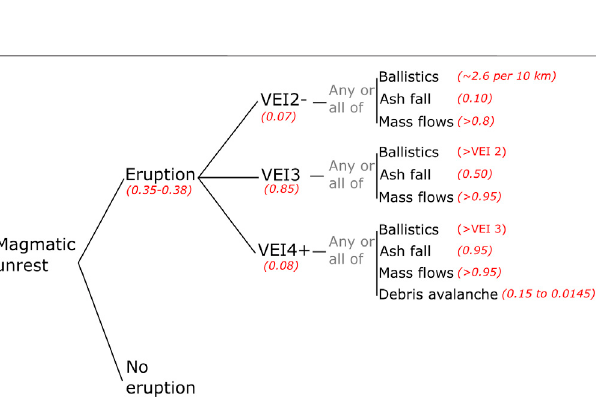
Frontiers in Earth Science |